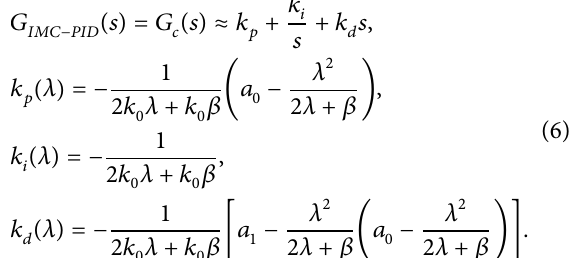
Figure 1: (a) Control schematic of Internal model control (IMC) system, (b) implemented structure of IMC-PID based wing vibration control